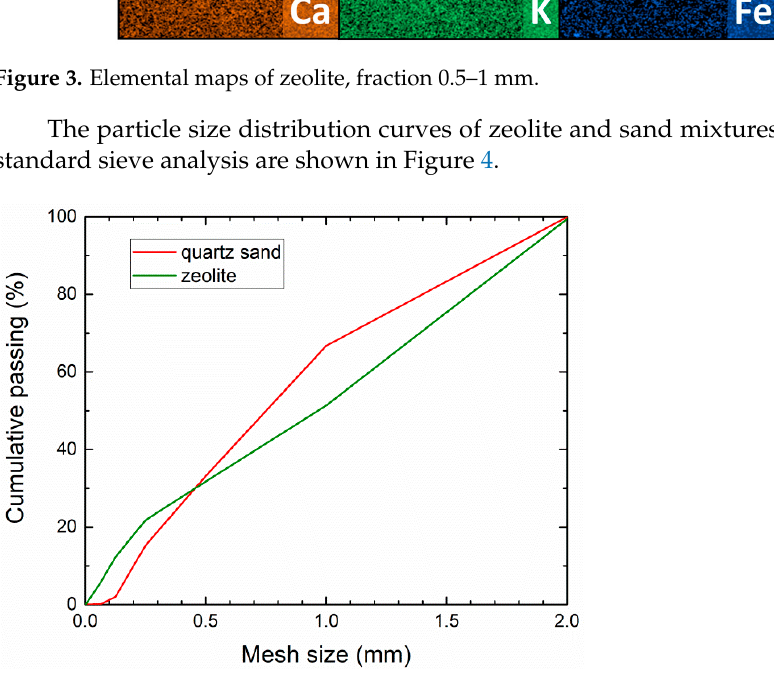
Figure 4. Particle size distribution of zeolite and quartz sand mixtures. The microstructure parameters of zeolite determined by MIP were as follows: total porosity 24.9%, average pore diameter 0.031 µ m, and total cumulative pore volume 0.16 cm 3 · g − 1 . Compared to river sand, which is assumed to have negligible porosity, zeolite was found to be highly porous.